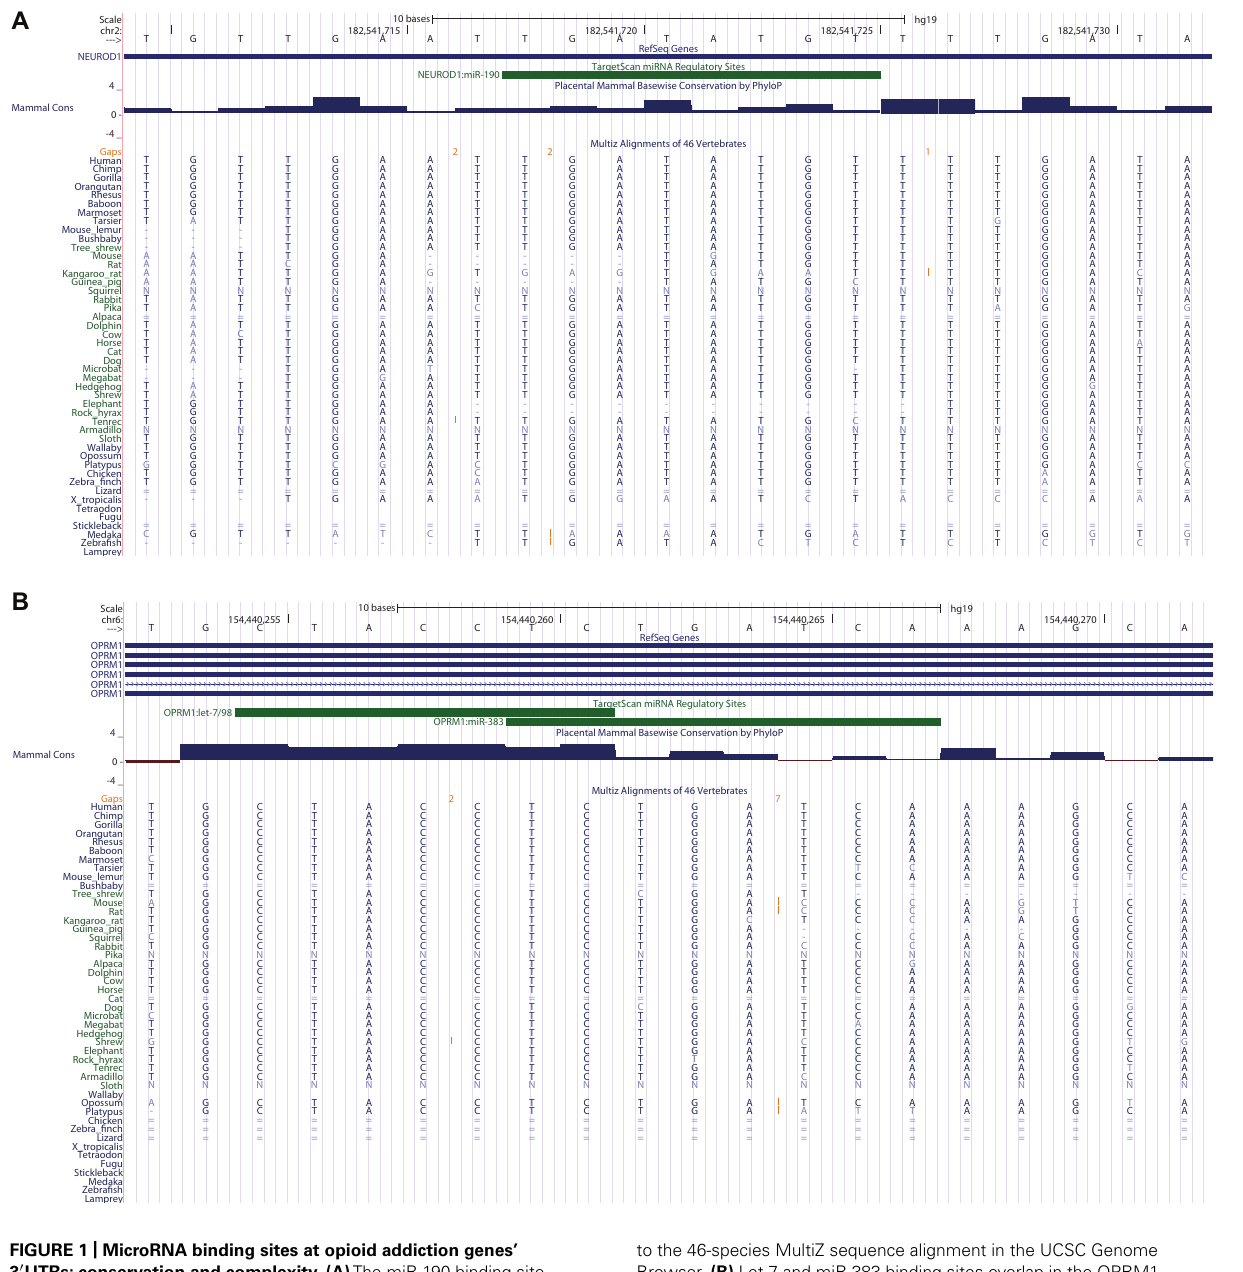
FIGURE 1 | MicroRNA binding sites at opioid addiction genes’ 3 (cid:2) UTRs: conservation and complexity. (A) The miR-190 binding site in the human NeuroD1 3 (cid:2) UTR is not conserved in the mouse, according